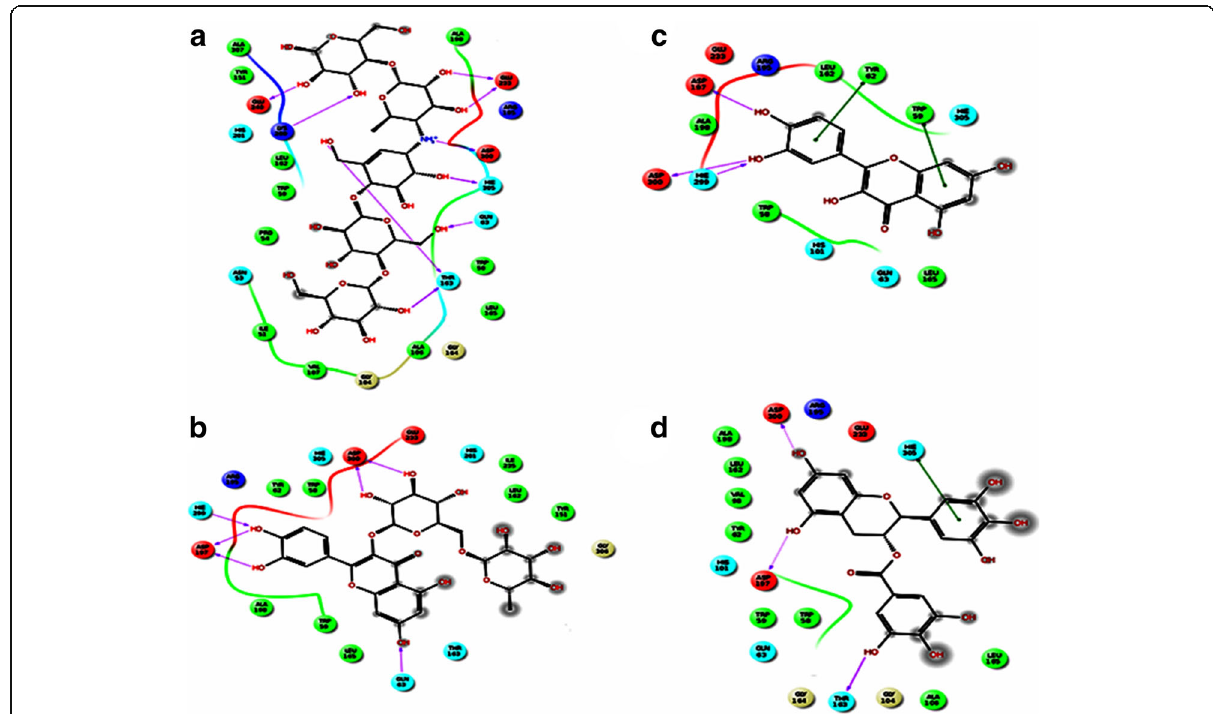
Fig. 7 Mode of binding of different compounds and acarbose in α -amylase enzyme active sites. a Acarbose, b Rutin, c Quercetin, and d Epigallocatechin gallate